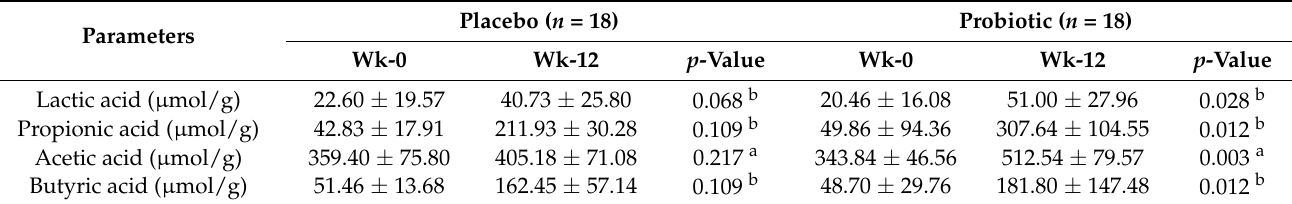
Table 6. The levels of SCFAs in feces at baseline and at the end of the